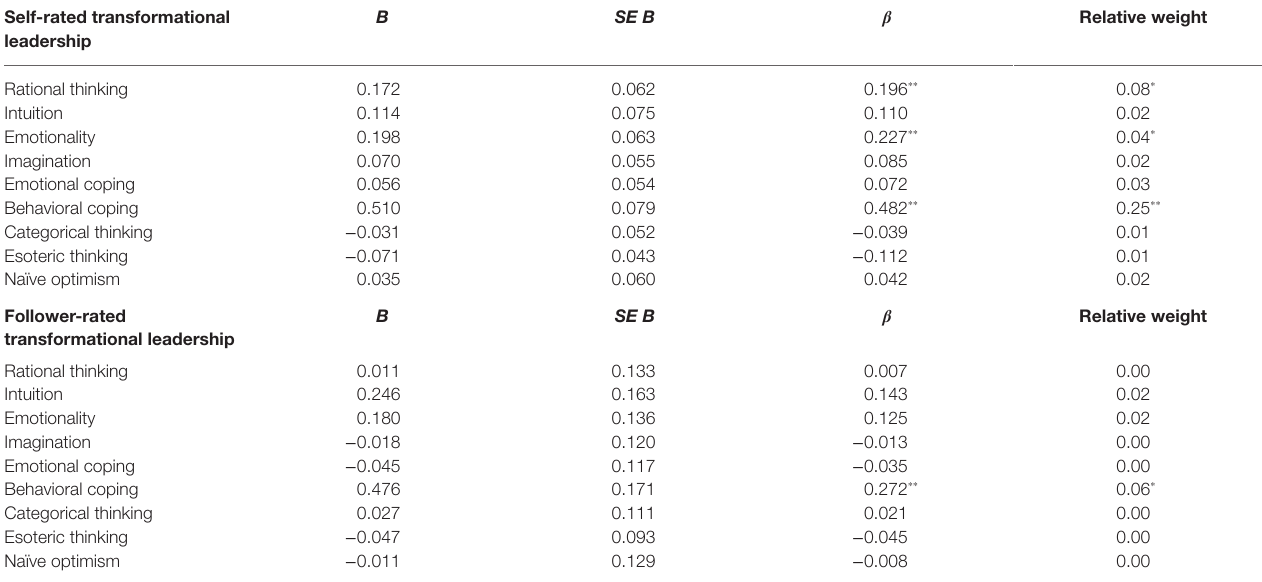
TABLE 3 | Regression statistics and relative weights for transformational leadership regressed on significantly correlated thinking style variables. Self-rated transformational leadership